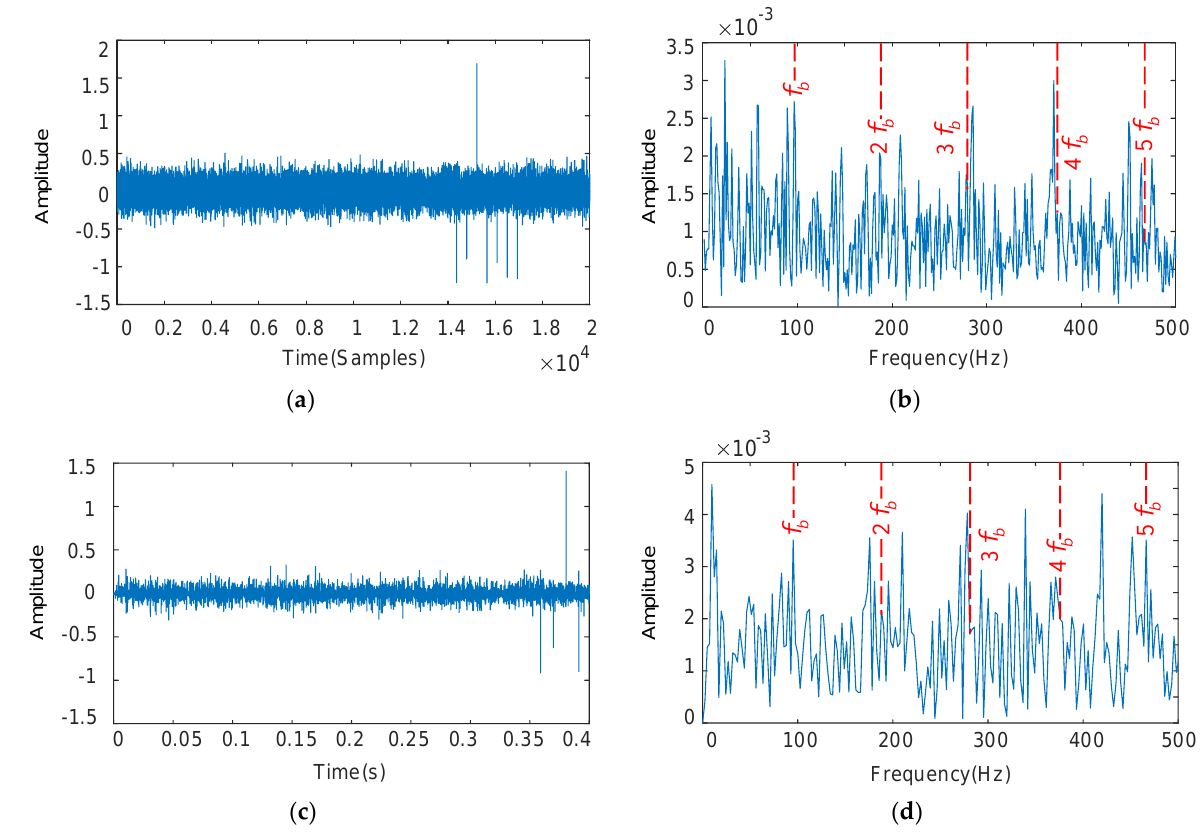
Figure 15. The bearing rollers deconvolution results by MCKD: the filtered time domain waveform and their spectrum ( a , b ); results obtained by MCKD + RSSD: time domain waveforms and their frequency spectrum ( c , d ).